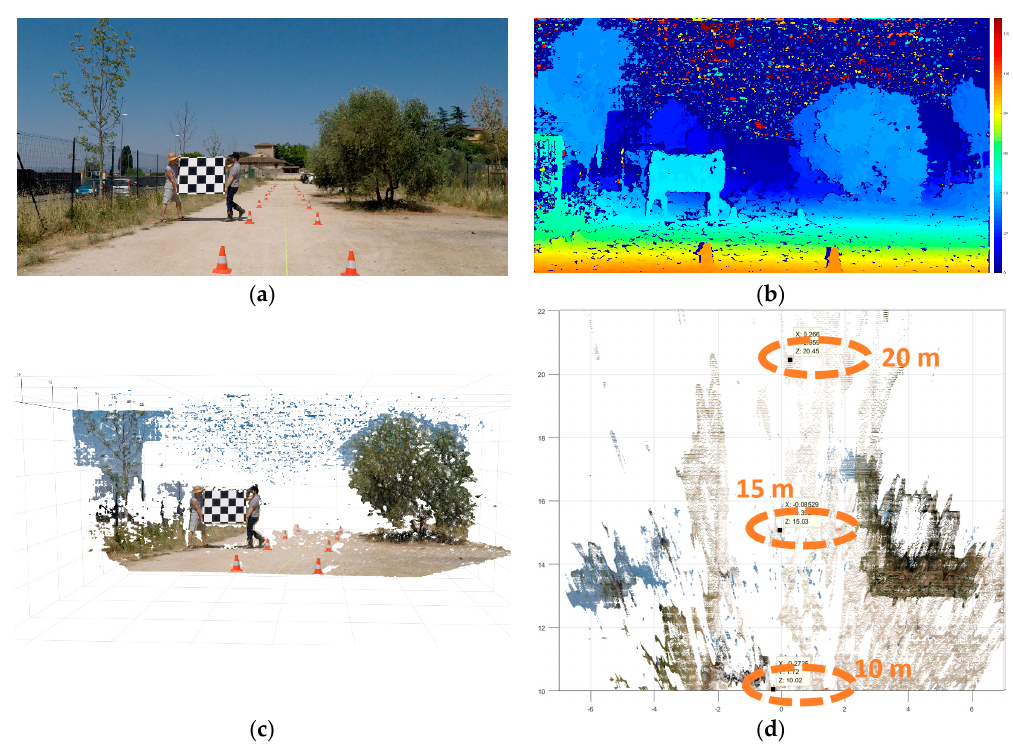
Figure 5. Figure 5. Depth accuracy quantification of the calibrated stereo camera (long-range camera rig). ( a ) Rectified left picture acquired by the long range stereo camera sensor; ( b ) Disparity Map of the scene (range from 0 to 128d); ( c ) Three-dimensional reconstruction or 3D point cloud of the scene imaged; ( d ) Top view of the 3D point cloud highlighting the location of the traffic cones originally placed at 10 m, 15 m, and 20 m. This 3D point cloud can be download according to Appendix B for a better assessment of the